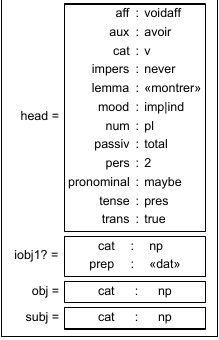
Figure 13: Entry of the verb montrez in the